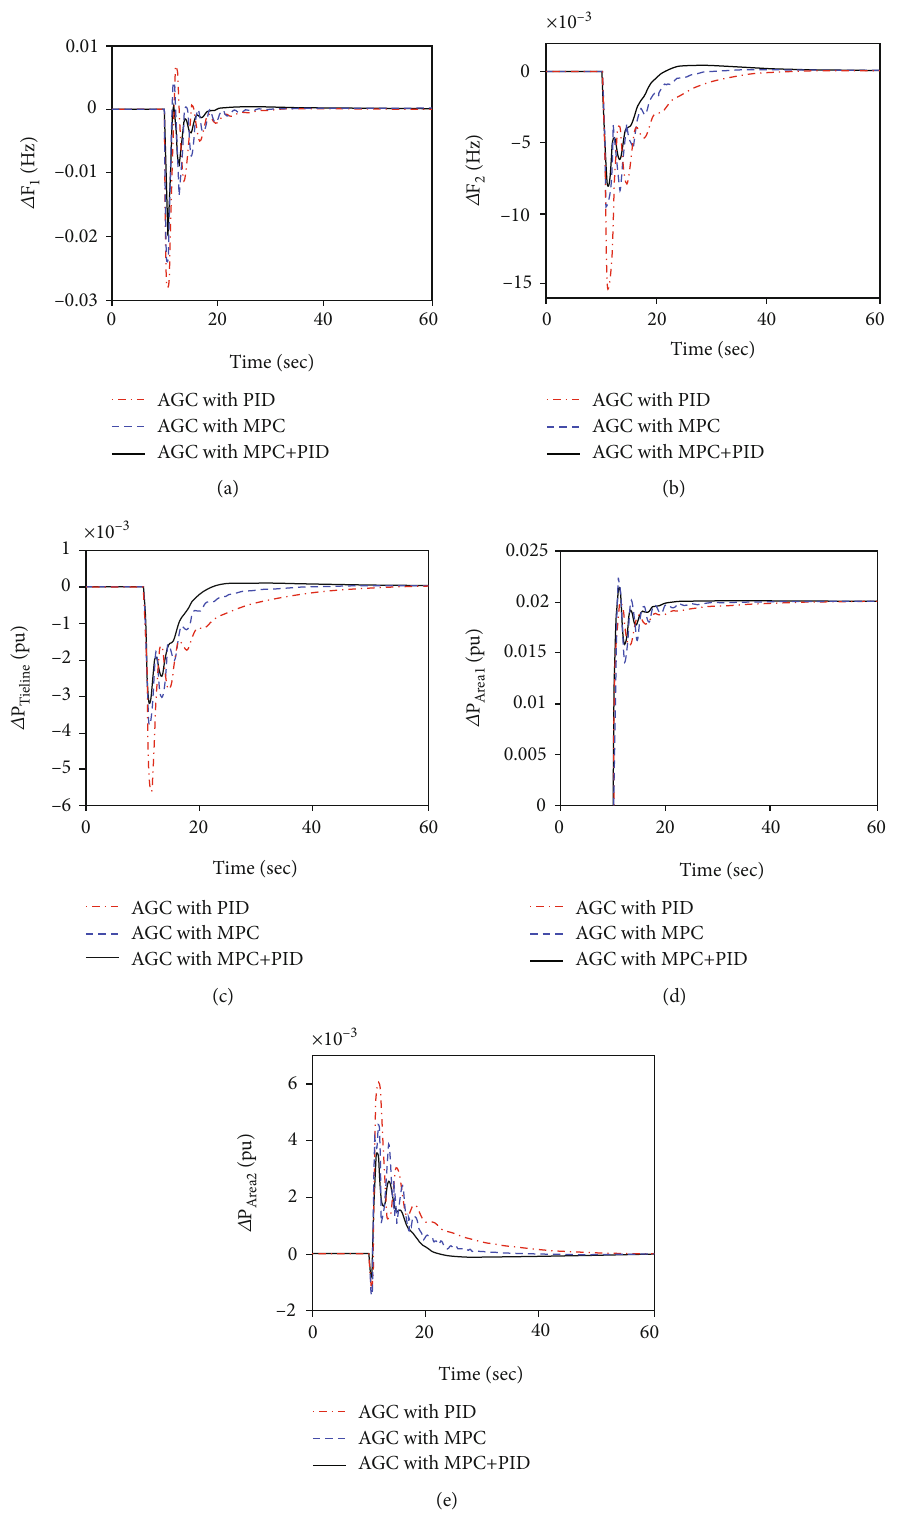
Δ F 1 vs. time, (b) 2 vs. time,